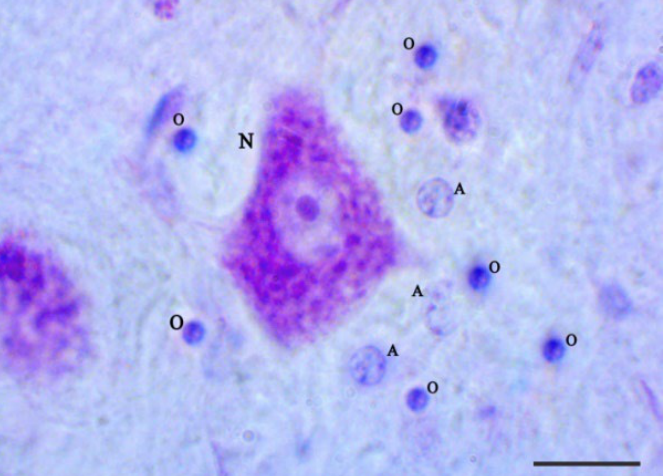
Figure 1. Photomicrographs of the Nissl-stained section are presented in high magnification. The scale bar represents 10 µm. In the Nissl-stained image: N = neuron, O = OLG, A = astrocyte. At higher magnification, note the presence of OLGs in the vicinity of the neurons and astrocytes in the brain. Astrocytes can be distinguished because of a characteristic pale nucleolus.